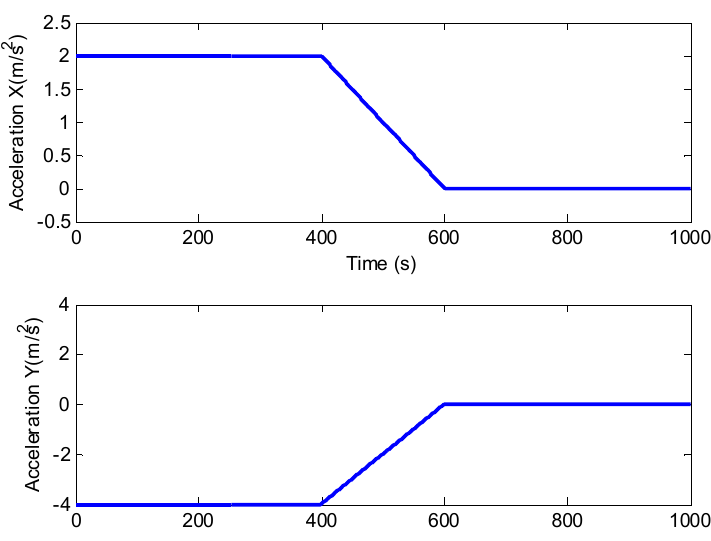
Figure 3. True acceleration during the trajectory.